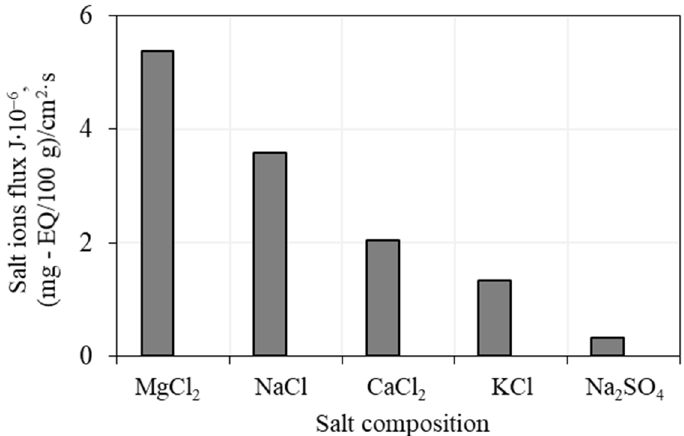
Figure 15. Average density of the flux of salt ions to a frozen hydrate-bearing sample for 4 h of interaction with 0.1 N MgCl 2 , NaCl, CaCl 2 , KCl, and NaSO 4 solutions, at − 6.5 °C and 0.1 MPa.